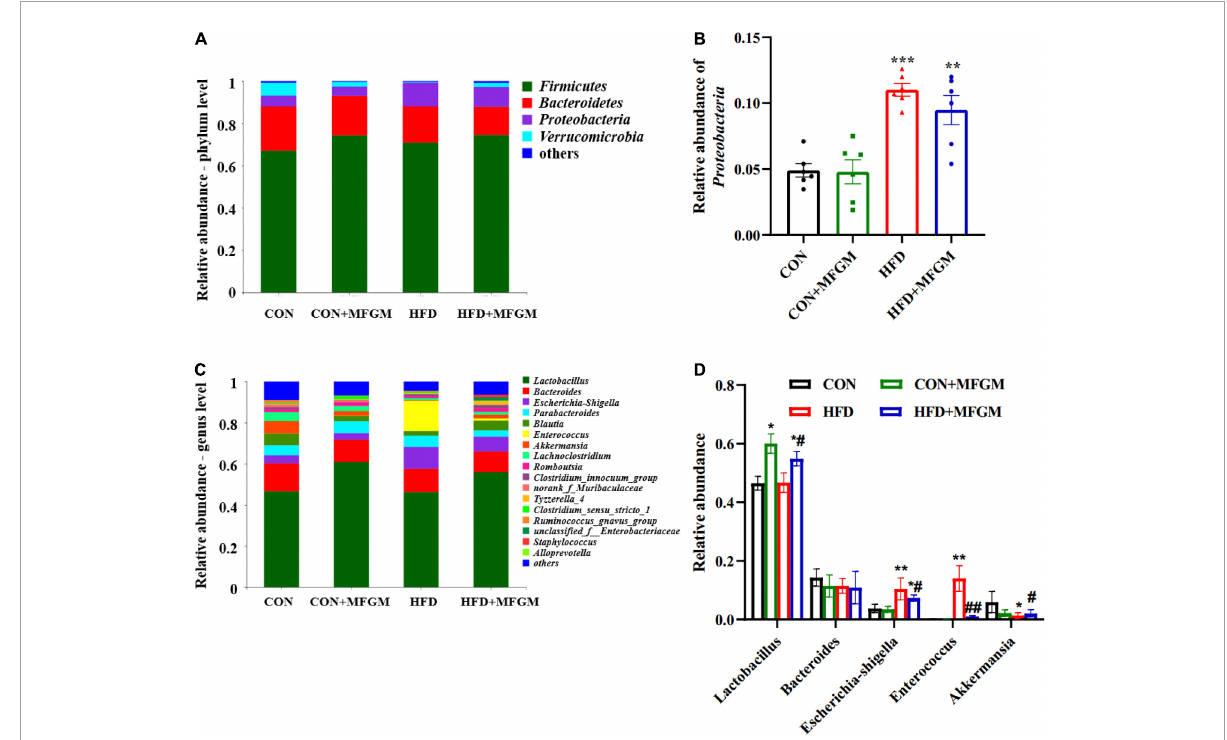
FIGURE4 Maternal supplementation with milk fat globule membrane during pregnancy and lactation regulated the composition of gut microbiota in weaned offspring from HFD dams. (A) Relative abundance of gut microbiota at the phylum level. (B) Relative abundance of Proteobacteria . (C,D) Relative abundance of gut microbiota at the genus level. Values are mean ± SEM, n = 5–6. * P < 0.05 vs. CON group. # P < 0.05 vs. HFD group. ** P < 0.01 vs. CON group. ## P < 0.01 vs. HFD group. *** P < 0.001 vs. CON group.